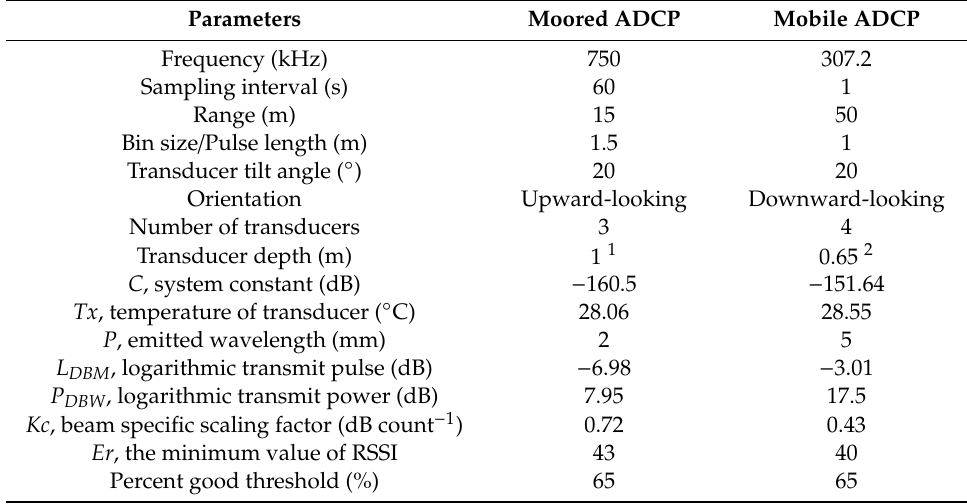
Table 1. Instruments and parameter configuration of both ADCP instruments for data acquisition and processing. Parameters Moored ADCP Mobile ADCP Frequency (kHz) 750